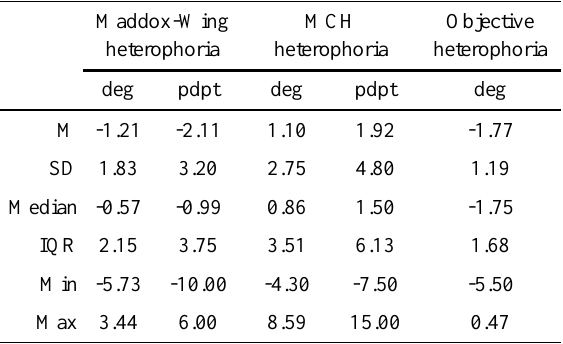
Table 1. Mean (M) values, standard deviation (SD), median, interquartile ranges (IQR), minimum and maximum values of Maddox-Wing, MCH and objective heterophoria (n = 65). Negative values correspond to exophoria, and positive values to